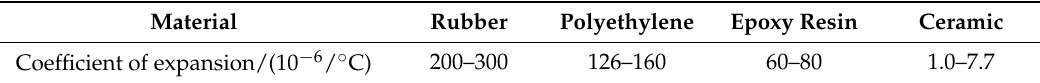
Table 1. Coefficients of (linear) thermal expansion of common bobbin materials. Material Rubber Polyethylene Epoxy Resin